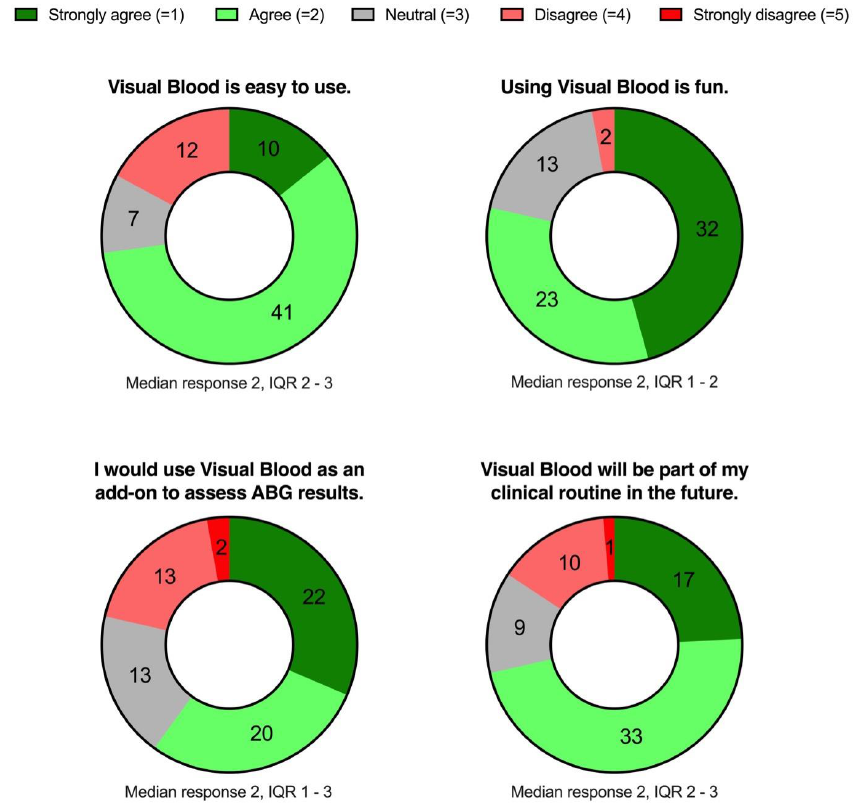
Figure 4. Doughnut charts presenting the participant opinions concerning Visual Blood. IQR, inter- interquartile range. N = quartile range. N = 70.